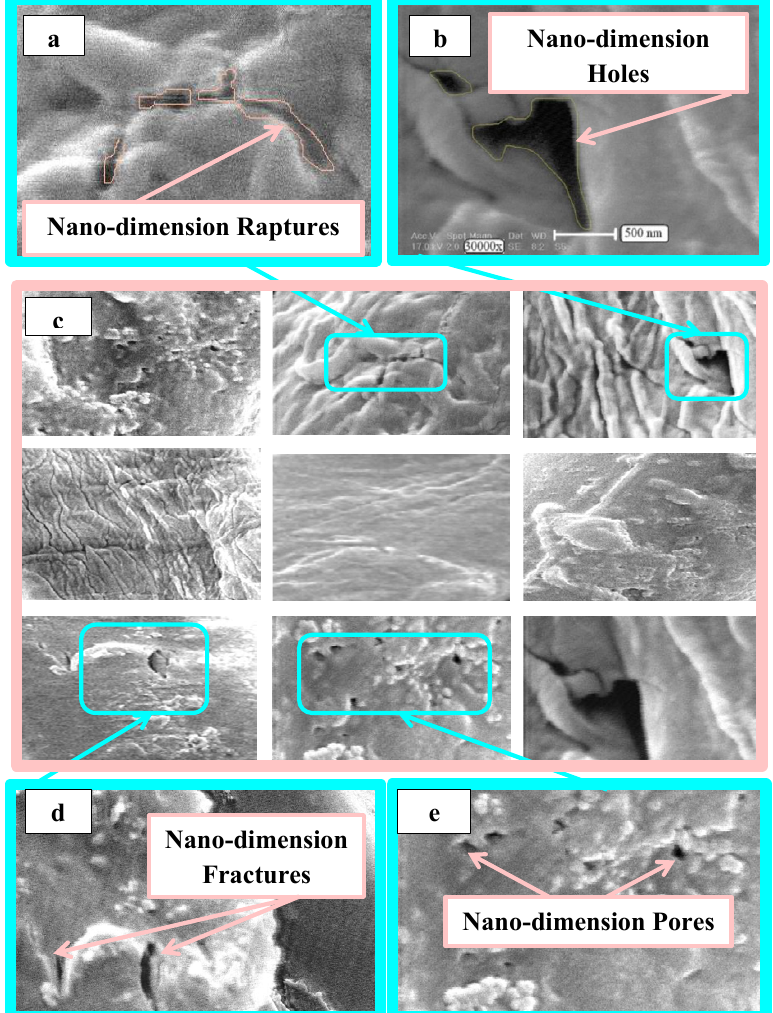
Fig. 5. Pores occurrence by SEM observations on the poly (ethylene terephthalate) surface: (a) nano-dimension raptures, (b) nano-dimension holes, (c) MAPS image, (d) nano-dimension fractures, (e) nano-dimension pores.